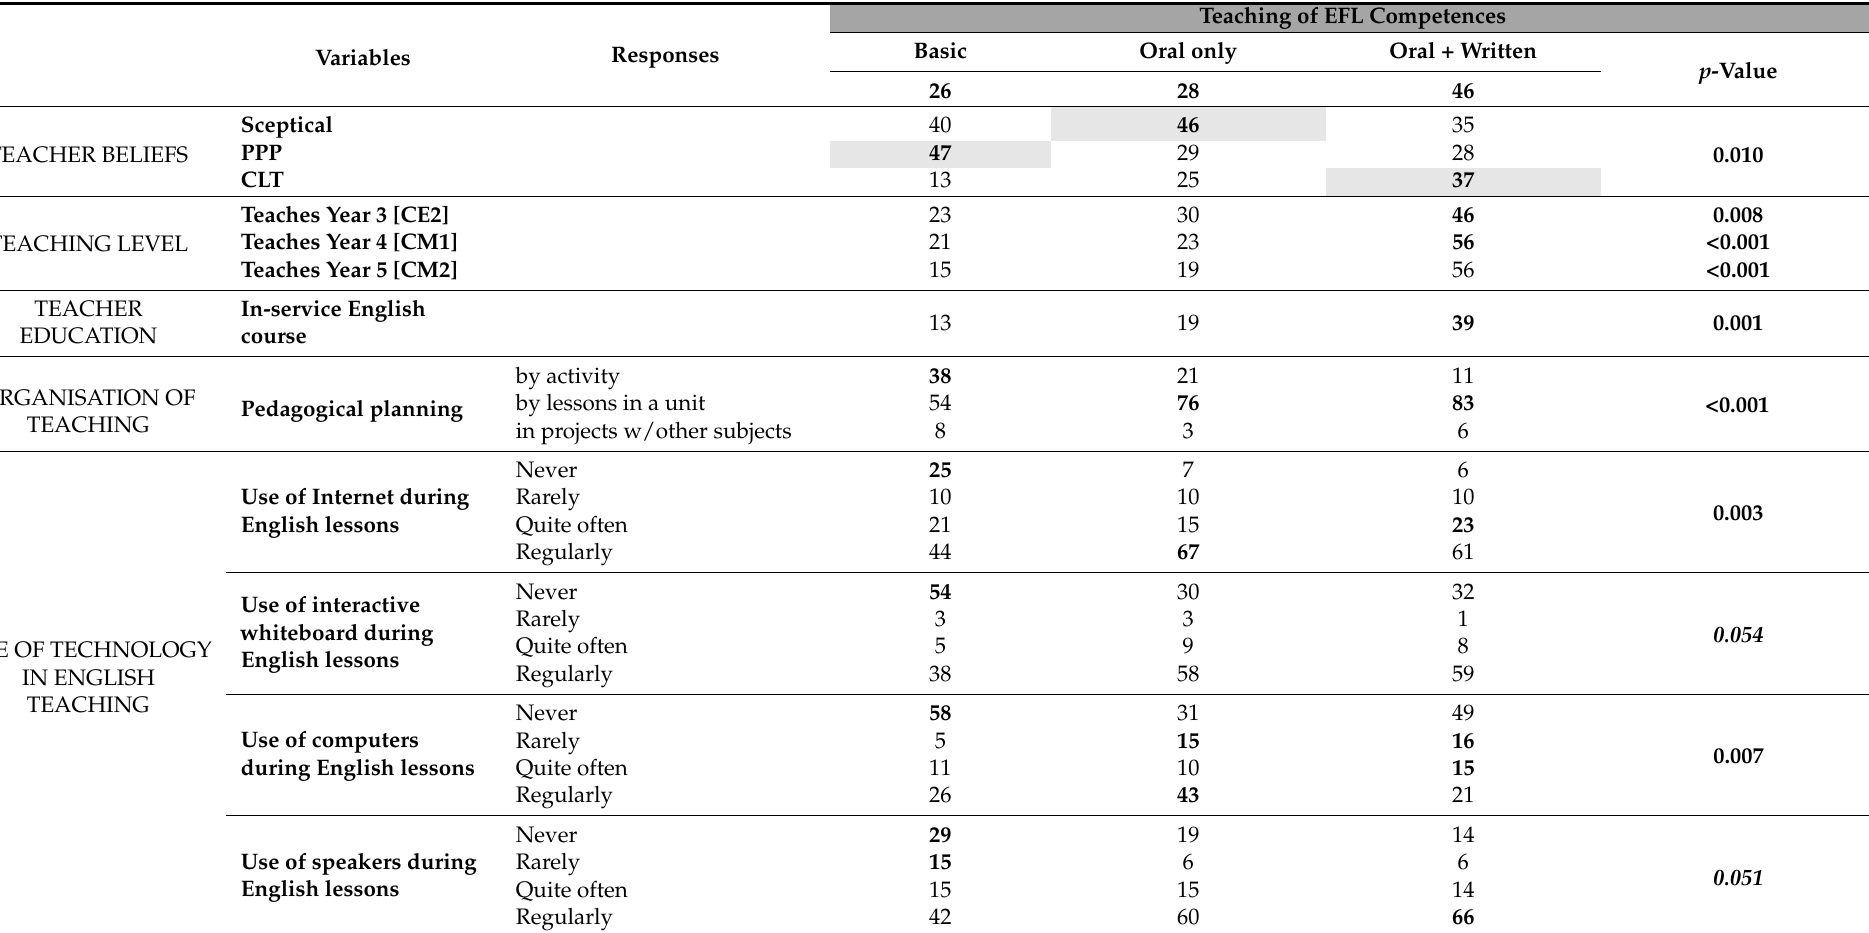
Table 5. Significant correlations between teacher beliefs and teaching